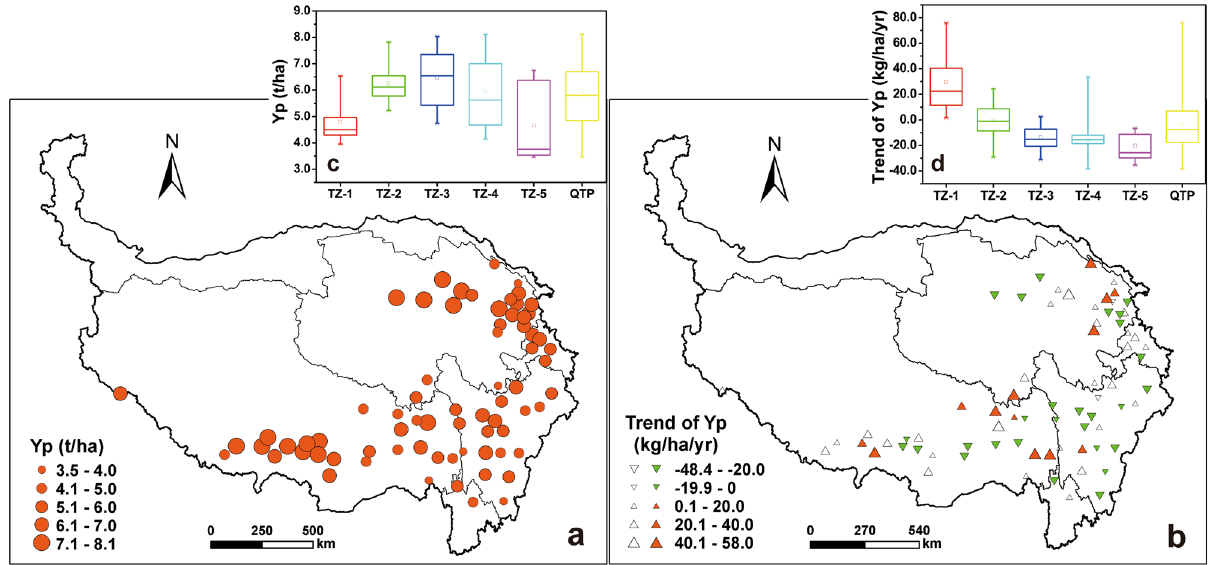
Figure 3. The annual average ( a ) and change trend ( b ) of HB potential yield in the Qinghai-Tibet Plateau during 1978–2017. Top-right box plots showed annual average ( c ) and change rate ( d ) of HB potential yield in different zones, respectively. Red and green triangles indicate significantly upward and downward trends ( p < 0.05), and hollow triangle indicates insignificant trend. The size of triangle is proportional to change magnitude. Maps were generated using ArcMap 10.7 software ( © ESRI, https:// desktop.arcgis.com).